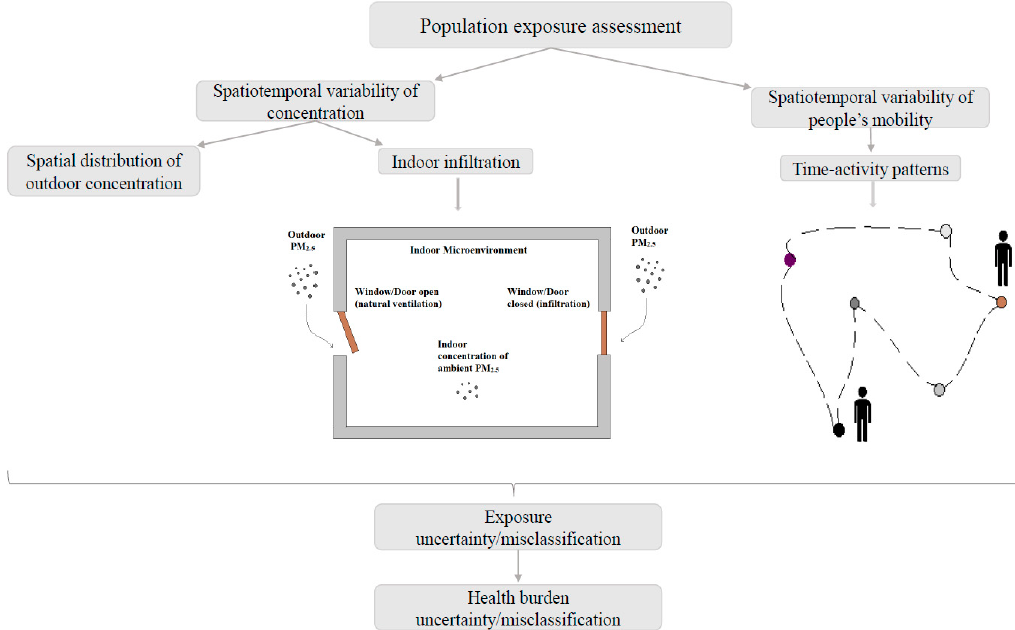
Figure 1. Schematic diagram of an exposure assessment structure for health burden misclassification.